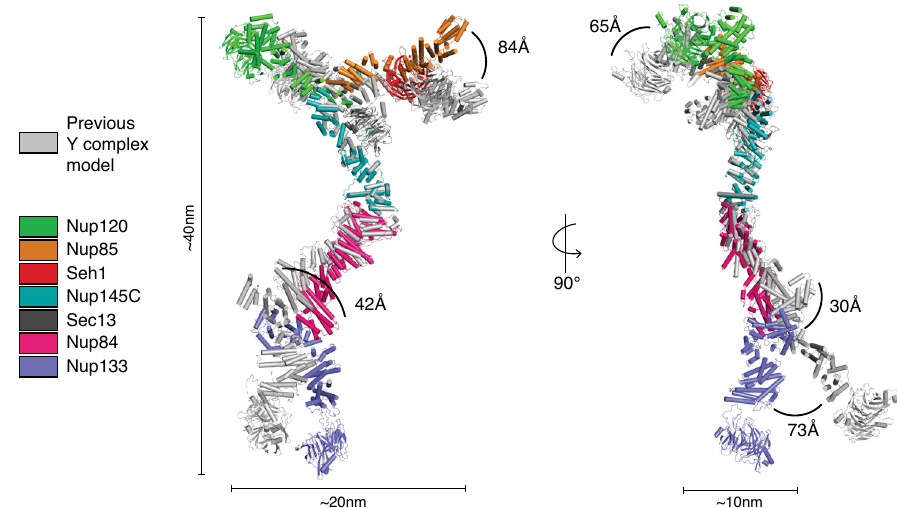
Fig. 6 Composite model of the Y complex. Composite model of the S. cerevisiae Y complex super-positioned with the previous S. cerevisiae composite model 26 , using Nup145C for matching. Colors of each nup are indicated in the key on the left. Overall dimensions of the Y complex are indicated. Conformational differences between the models are shown by arcs between the same nups, with the distance of each